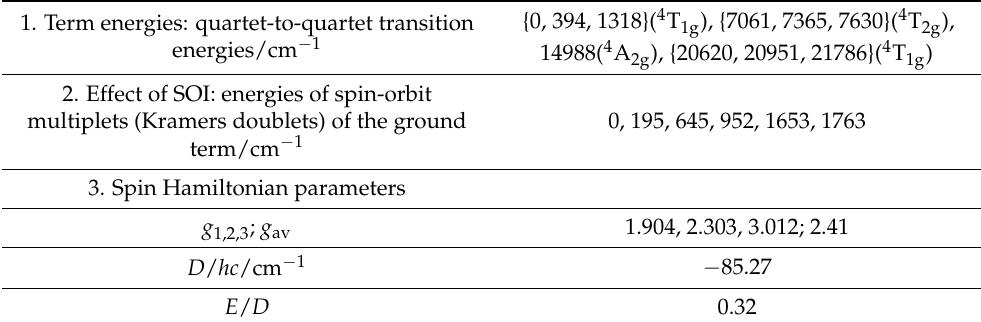
Table 2. Calculated (CASSCF&NEVPT2) energies and magnetic parameters for complex 1 .